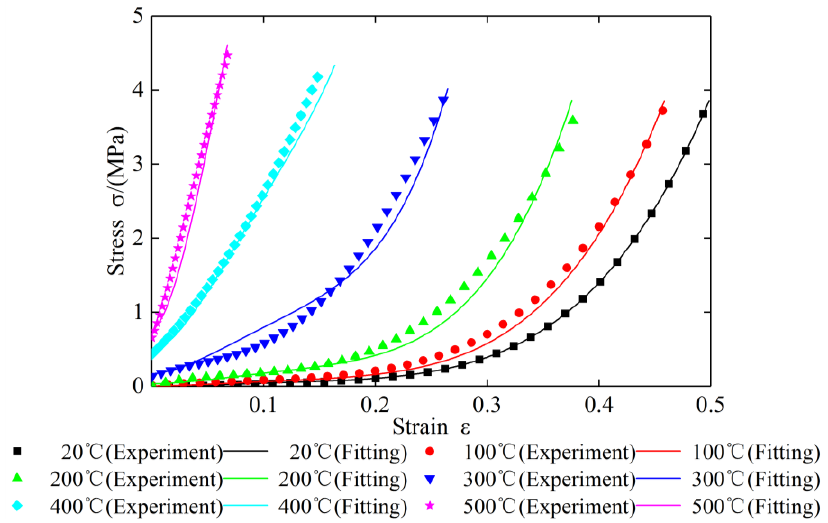
Figure 17. Stress – strain curves of specimen 1 at different temperatures and their fitting curves. Table 4. The deviation between the tested stress and the fitted stress for specimen 1 under 100 °C. ε